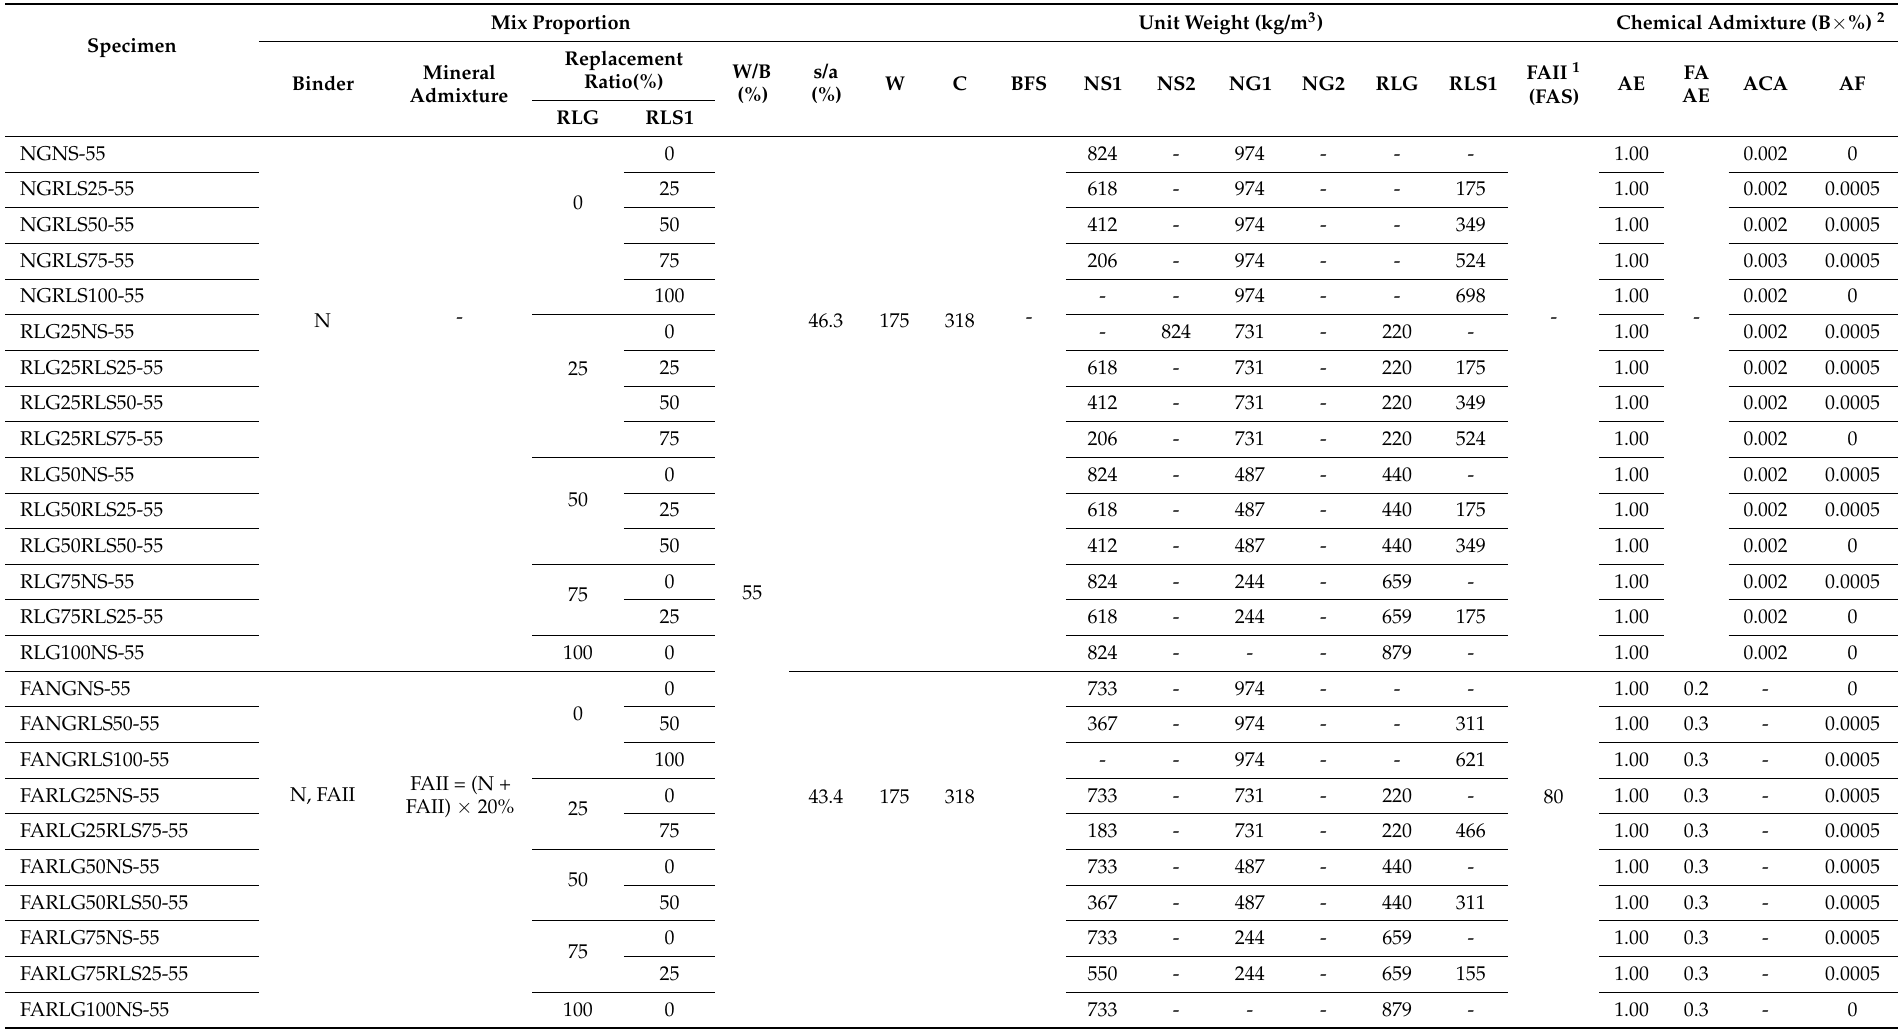
Table 8. Concrete mix